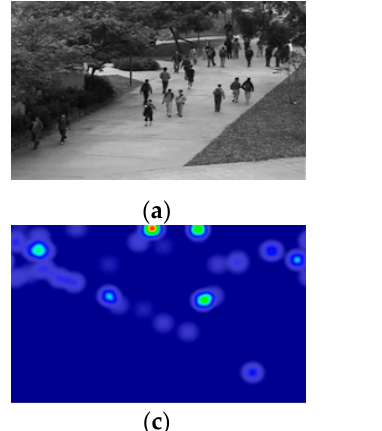
Figure 11. The MAE and MSE of different methods for the UCSD dataset. 6. Conclusions In this paper, we proposed a new convolution neural network called DSA-CNN to estimate density map for crowd counting. The purpose of the proposed algorithm is to count the number of people in the image accurately. In order to overcome the influence of camera perspective on crowd counting, the proposed method adopted different sizes of filters in the network and combines them